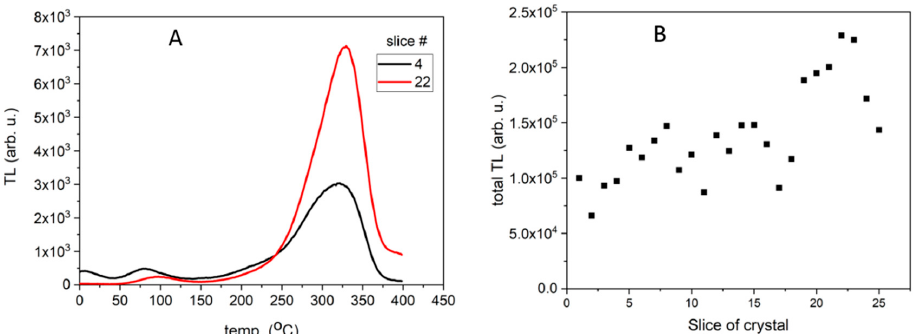
Figure 3. TL signal of LMP doped with 0.8-mol% Tm and 10-mol% B. ( A )—TL glow curves for slices #4 and #22. ( B )—Integrated TL signal in the temperature range between 20 °C and 400 °C calculated for all TL curves. The samples were irradiated with 0.2 Gy of beta rays in the Risø reader. Slice of crystal—numbers represent labelling of samples along the crystal length, as illustrated in Figure 1.